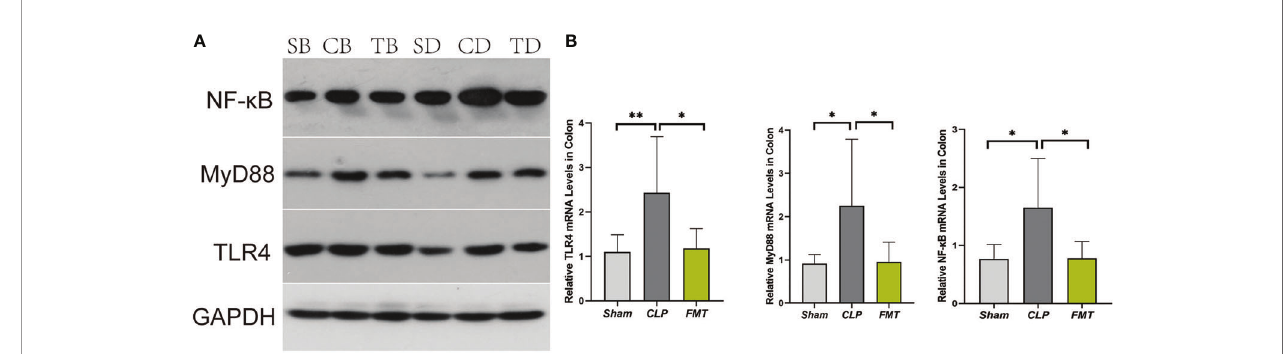
FIGURE 6 | TLR4, MyD88, and NF- k B expression and mRNA levels. (A) Expression of TLR4, MyD88, and NF- k B compared to GAPDH protein among Sham, CLP, and FMT groups at 24 and 48 h. SB, CB, TB, SD, CD, and TD represent 24 h Sham, CLP, and FMT groups and 48 h Sham, CLP, and FMT groups, respectively. (B) Relative TLR4, MyD88, and NF- k B levels in the colon. * P < 0.05, ** P <